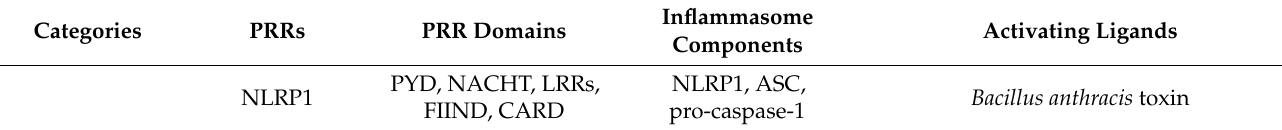
Table 1. Summary of the structure and activating ligands of